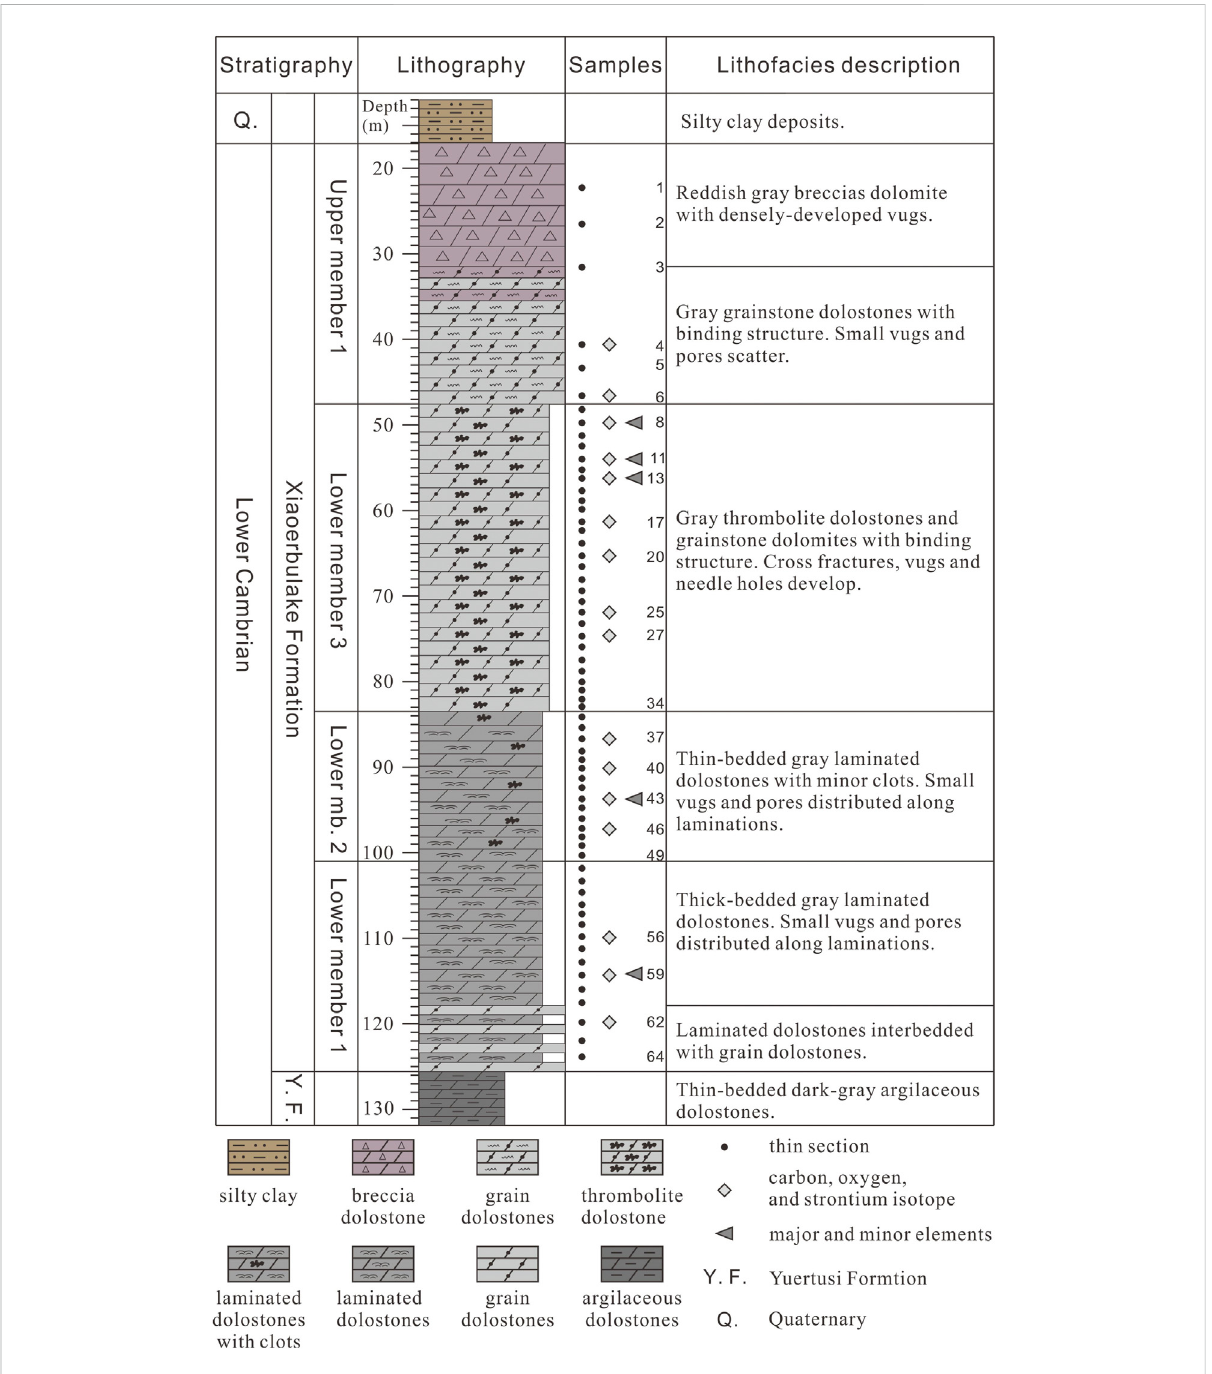
FIGURE 2 Comprehensive stratigraphic column of Well